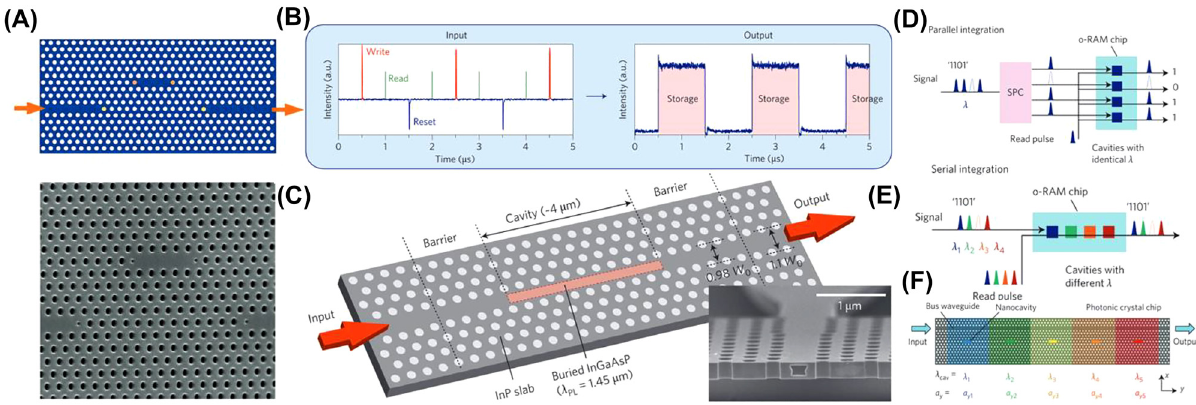
Figure 9: Tunable photonic crystals. (A) Schematic (Top) and SEM image (Bottom) of the photonic crystal nanocavity [105]. (B) Operational principleoftheall-opticalRAMshowingtwofullcyclesofwrite,storage,anderaseoperations.Inputwaveform(left)isconsistedofwrite,read, and reset pulses superimposed on the continuous wavelength bias [108]. (C) Schematic of the InGaAsP buried heterostructure in InP-based photonic crystal. The inset shows the cross-sectional SEM image of the fabricated structure [108]. (D – E) Conceptual illustration for parallel (D) and serial (E) integration of PhC devices. (F) Nanocavities with different resonant wavelengths that are side-coupled are also coupled to a common bus waveguide, forming a cascaded con fi guration